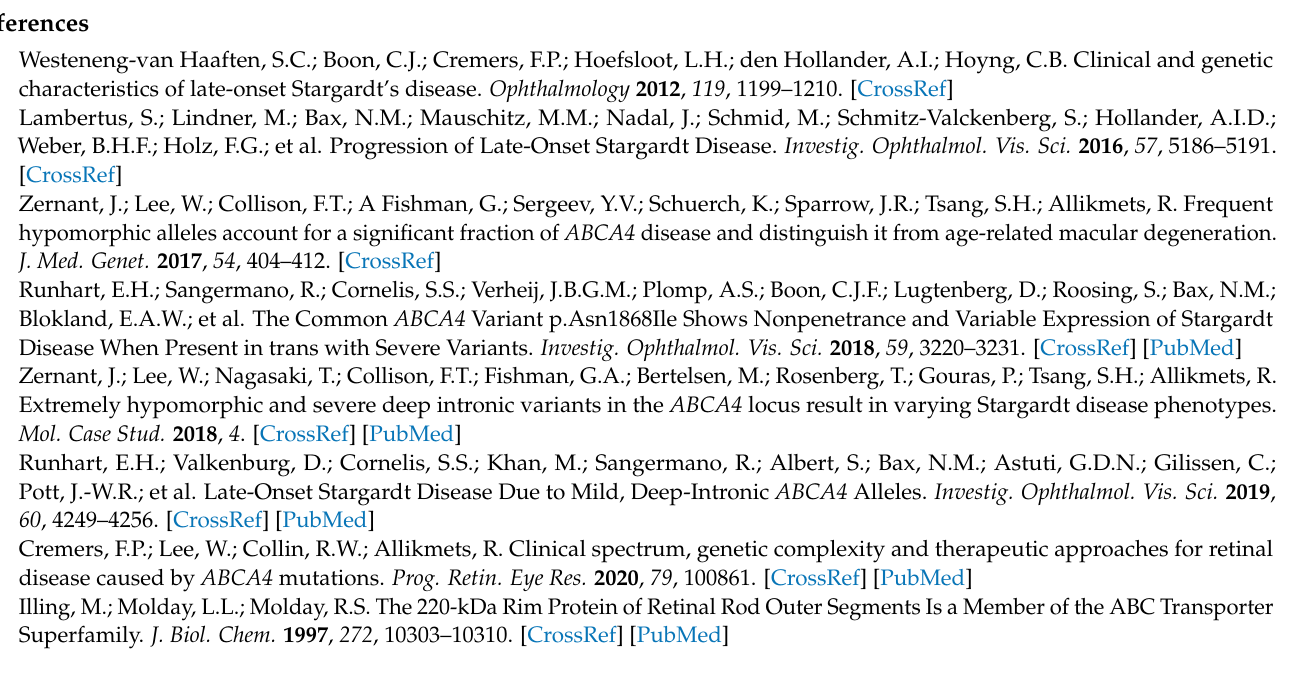
clones, Table S3: Primers for RT-PCR analysis, Table S4: Semi-quantification analysis of transcripts from RT-PCR products. Table S5: Semi-quantification analysis of the RT-PCR products from non- treated (NT) or AON/SON-treated samples. The amount of the different transcripts is represented as a percent (%) of the total transcript for each condition or lane. The average of two independent experiments, followed by two independent semi-quantification for each replicate is provided. SD: standard